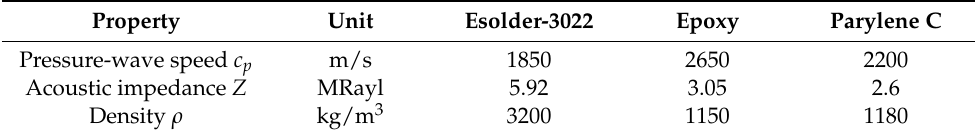
Table 3. Parameters of materials used for finite element analysis.